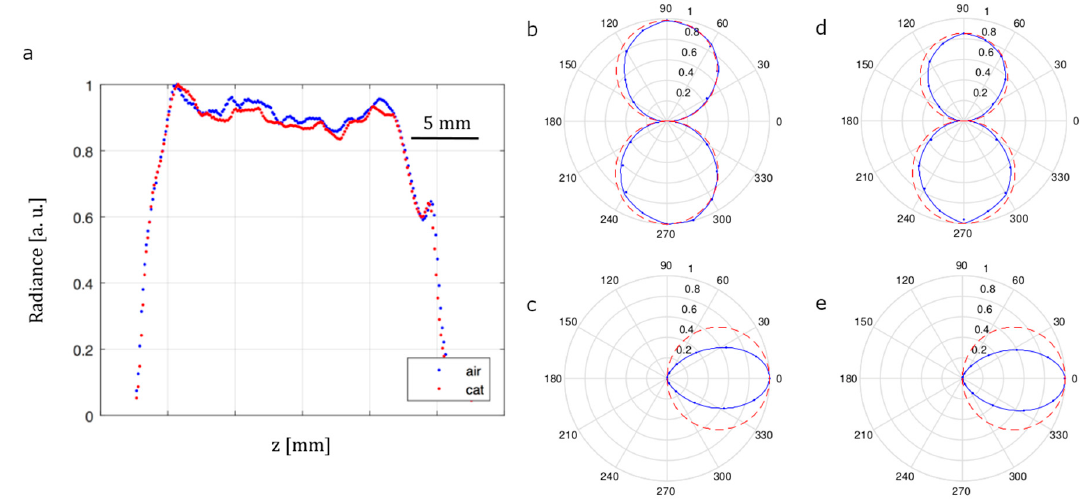
Figure 3. ( a ) Normalized longitudinal radiance profile of a radial/cylindrical light diffuser for endovascular illumination (at 652 nm in air (blue curve) or placed into a transparent vascular catheter sheathing (red curve, “cat”); = 0 deg.). The fiber distal end is located on the right. ( b ) Polar radiance profile of radial/cylindrical light diffuser for endovascular illumination (at 652 nm in air; φ = 0 deg.; arbitrary units). Red dotted line: Lambertian profile; blue line: measurements. Measurements and Lambertian profiles are superimposed at 90° and 270°. ( c ) Azimuthal radiance profile of radial/cylindrical light diffuser for endovascular illumination (at 652 nm in air; θ = 90 deg.; arbitrary units). Red dotted line: Lambertian profile; blue line: measurements. Measurements and Lambertian profiles are superimposed at φ = 0°. ( d ) Polar radiance profile of a radial/cylindrical light diffuser for endovascular illumination placed into a standard transparent vascular catheter (at 652 nm; φ = 0 deg.; arbitrary units) in air. Red dotted line: Lambertian profile; blue line: measurements. Measurements and Lambertian profiles are superimposed at 90° and 270°. ( e ) Azimuthal radiance profile of a radial/cylindrical light diffuser for endovascular illumination placed into a standard transparent vascular catheter (at 652 nm, θ = 90 deg.; arbitrary units) in air. Red dotted line: Lambertian profile; blue line: measurements. Measurements and Lambertian profiles are superimposed at φ = 0°.